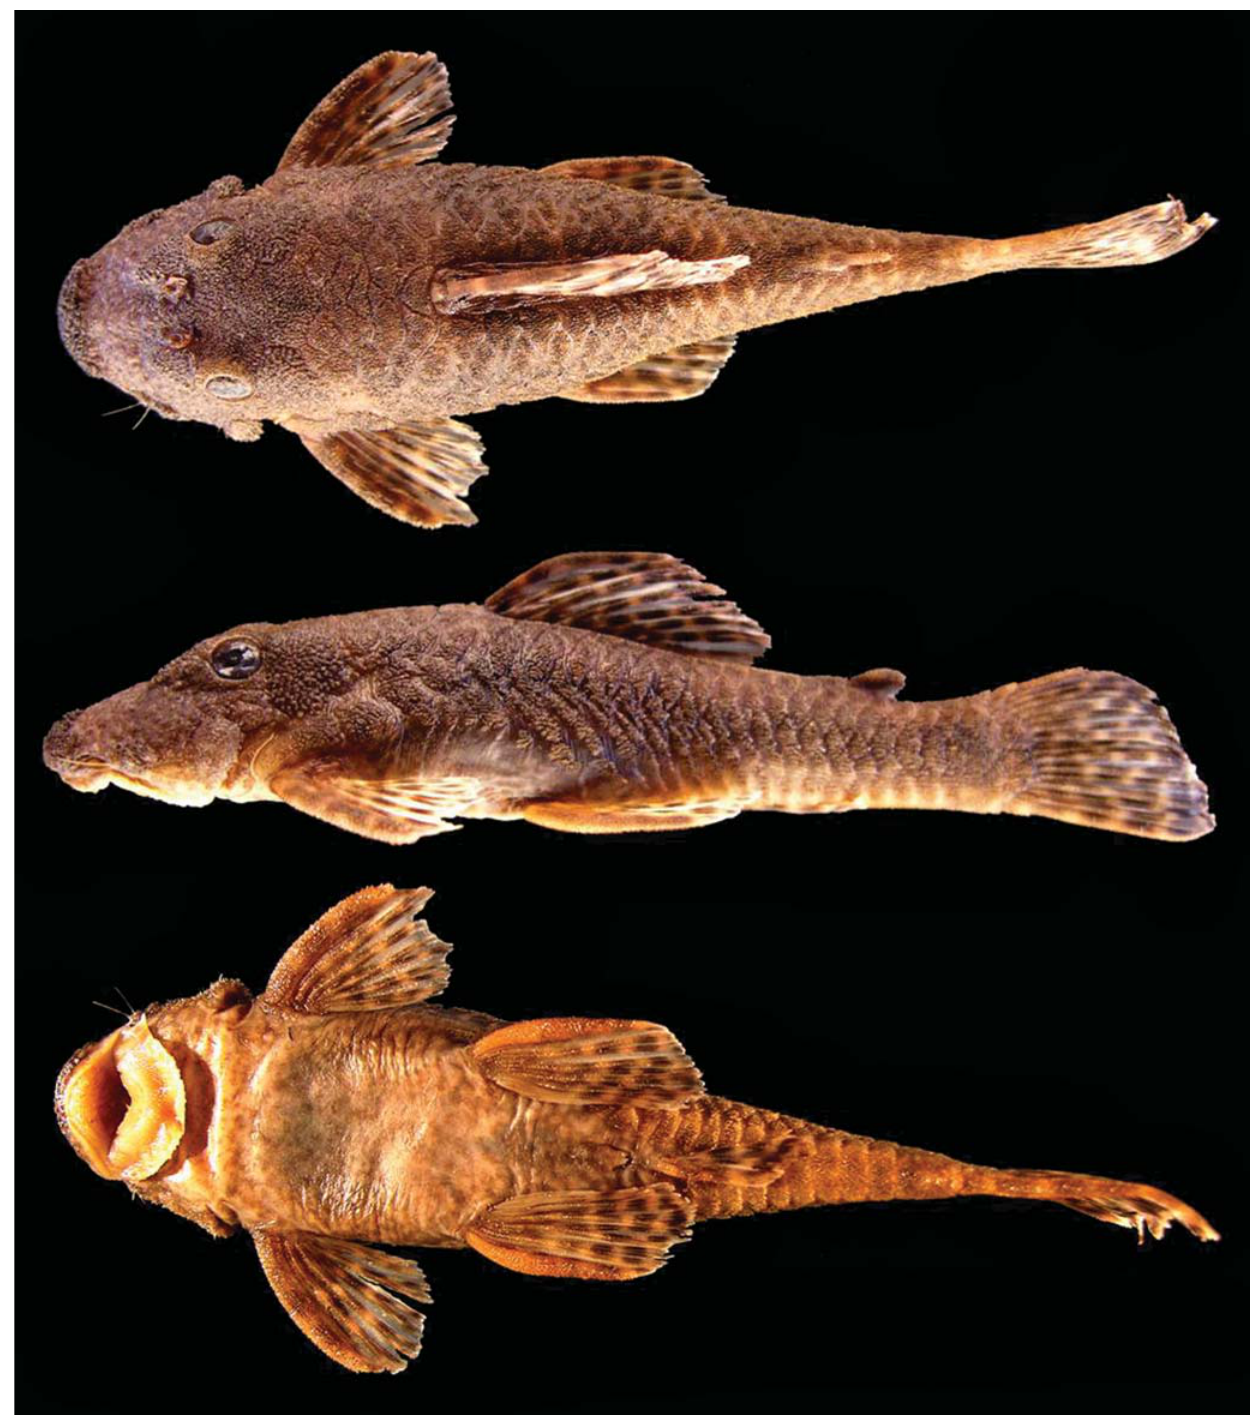
Fig. 1. Neblinichthys brevibracchium , holotype, CSBD 1653, 73.3 mm SL, lower Kukui River at Jawalla, upper Mazaruni River drainage,